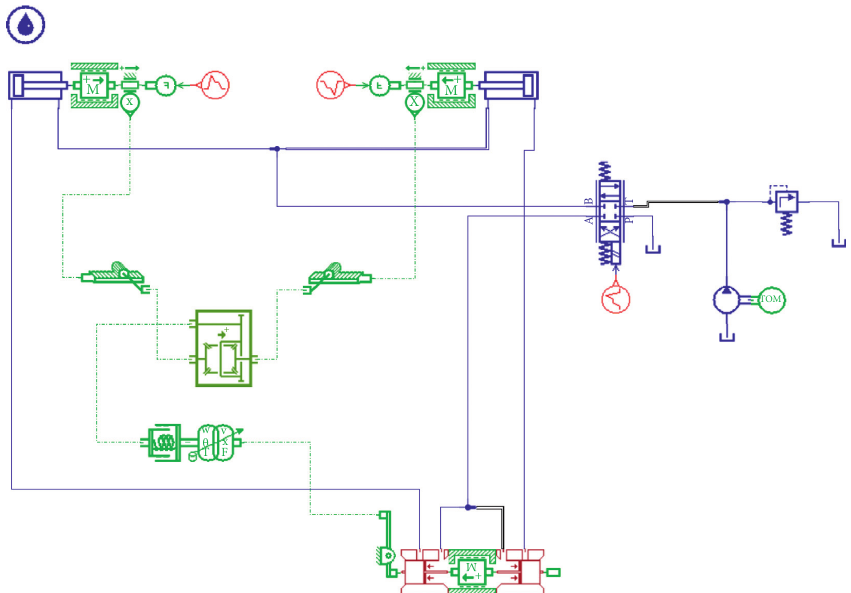
Figure 7: Modeling diagram of AMESim hydraulic system.